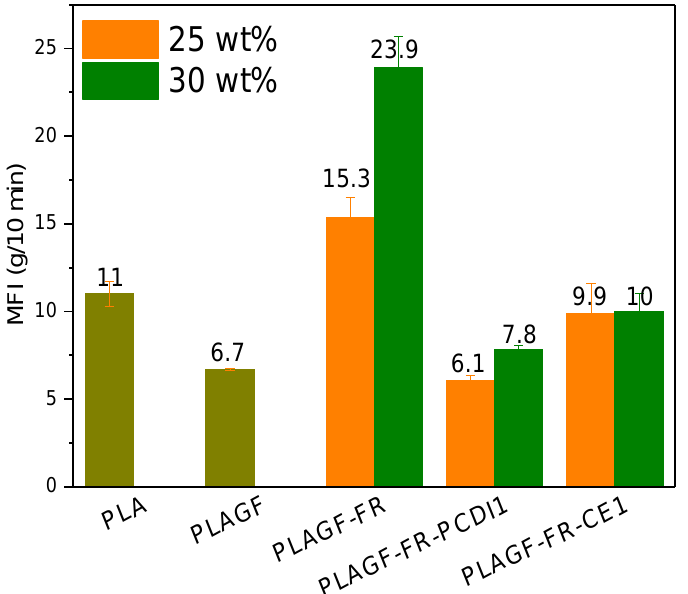
Figure 1. MFI results of PLA and PLA composites with and without FR and chain modifiers at 190 °C and 2.16 kg.